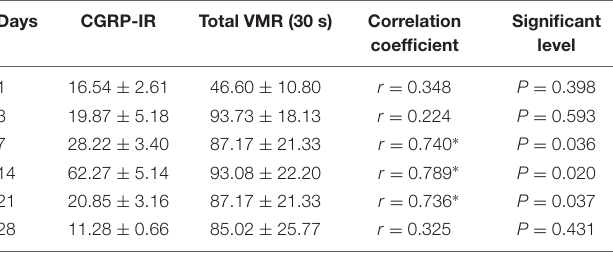
TABLE 2 | The correlation between CGRP level in DRG and total VMR in TNBS-treated rats. Days CGRP-IR Total VMR (30 s) Correlation